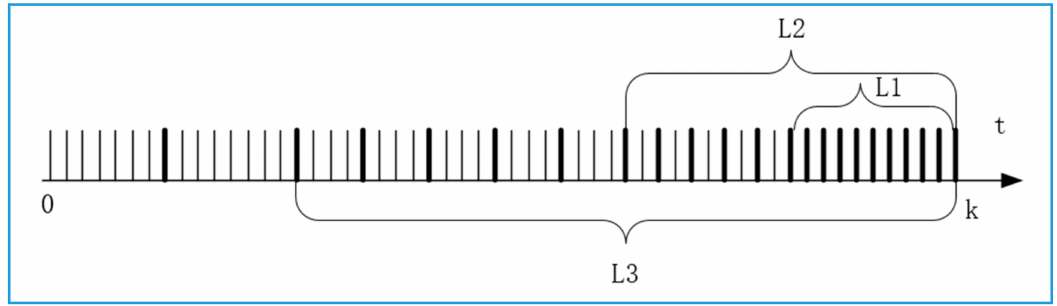
Figure 10. Schematic diagram of extracting function value by the first enlargement of step size ( nN t < k ≤ n 2 N t and k ≥ n 2 N t